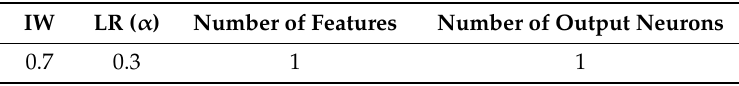
Table 2. Fixed values for ANN computation.